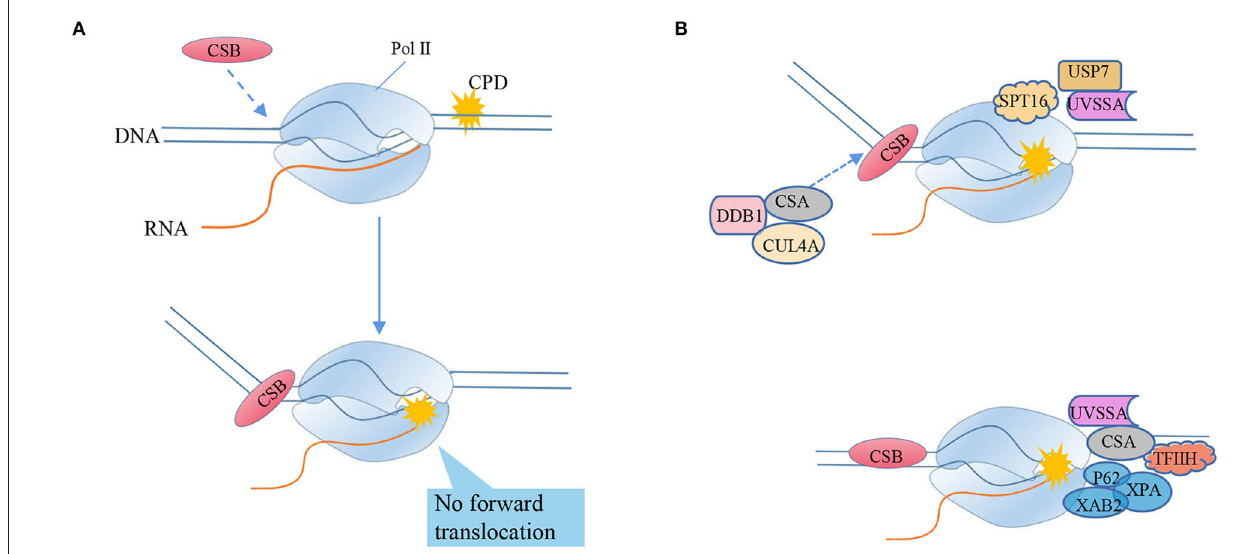
FIGURE 5 | RNA polymerase II bypasses the transcriptional blocking damage cyclobutane pyrimidine dimer (CPD) triggers TC-NER repair. (A) CSB recognizes stagnant Pol II and binds to its upstream DNA, and uses its ATPase activity to push Pol II forward by translocating from 3’to 5’on the transcription template